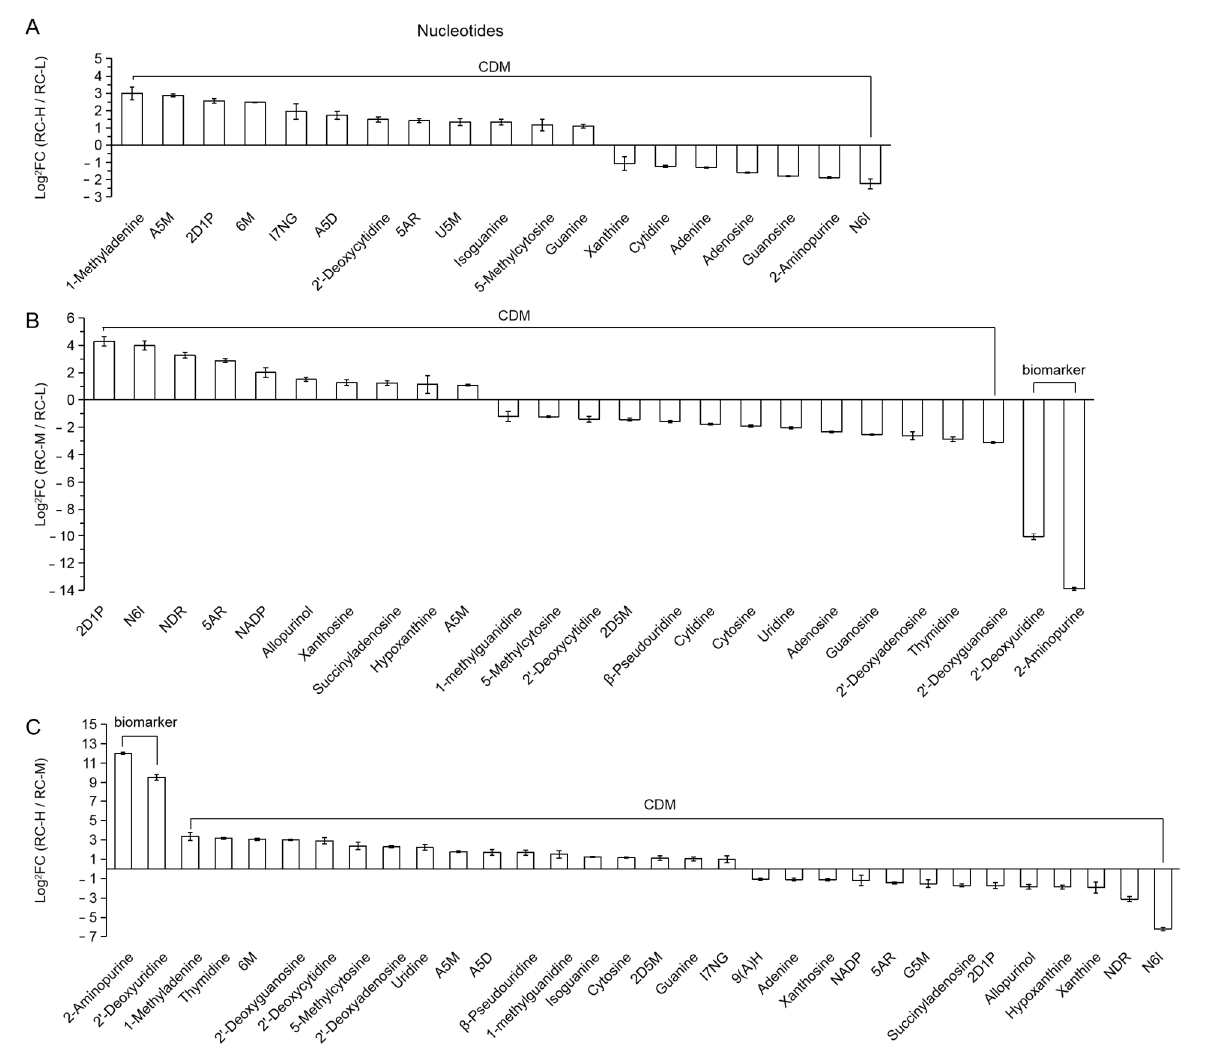
Figure 18. Comparison of differential metabolites of nucleotides between RC-L, RC-M and RC-H. These were 19 CDMs for RC-H vs. RC-L ( A ), 2 biomarkers and 23 CDMs for RC-M vs. RC-L ( B ), and 2 biomarkers and 30 CDMs for RC-H vs. RC-M ( C ). Upregulation denotes that the content of a metabolite in RC increased with elevation between two altitudes, and the opposite for downregulation The Y-axis is shown as Log 2 FC values for the convenience of visual presentation (Note: The up-amplitude in the text refers to the FC value). The X-axis denotes metabolite names.